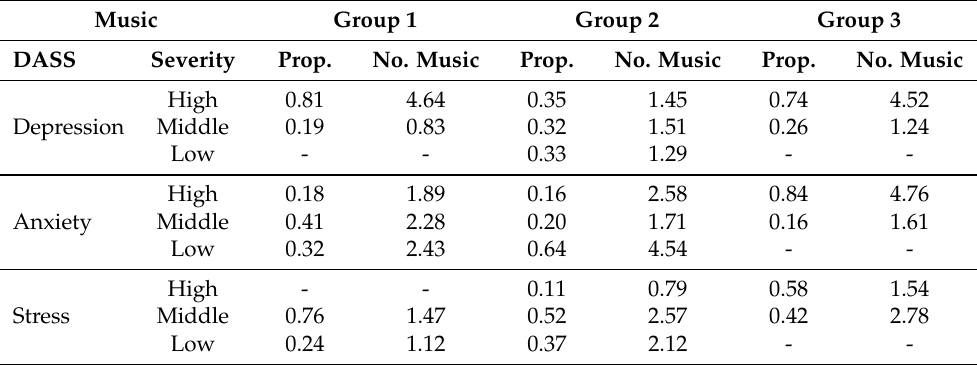
Table 1. Results of proportion and average number of music tracks by DASS